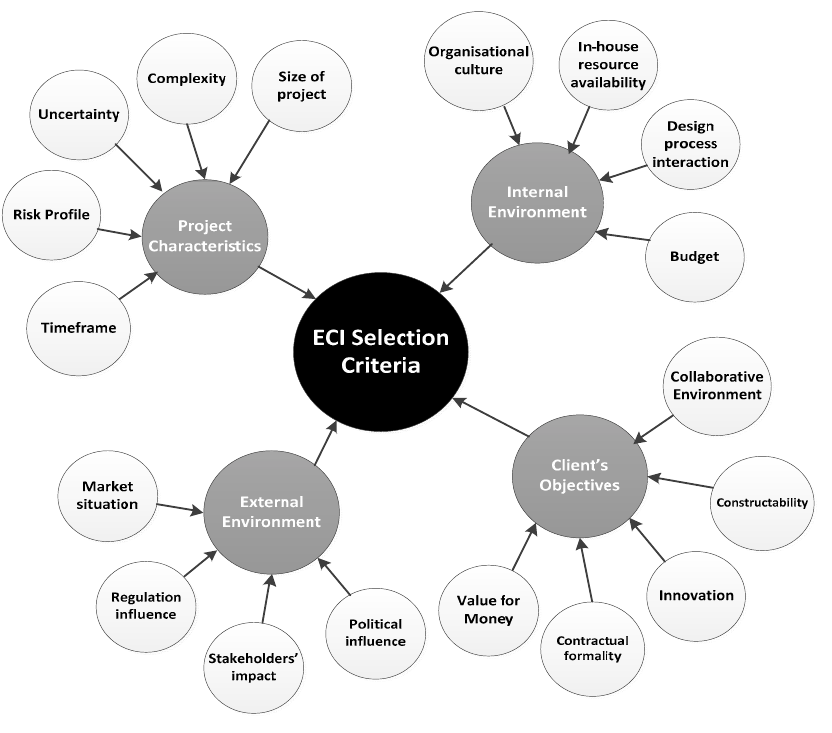
Figure 1. ECI Selection